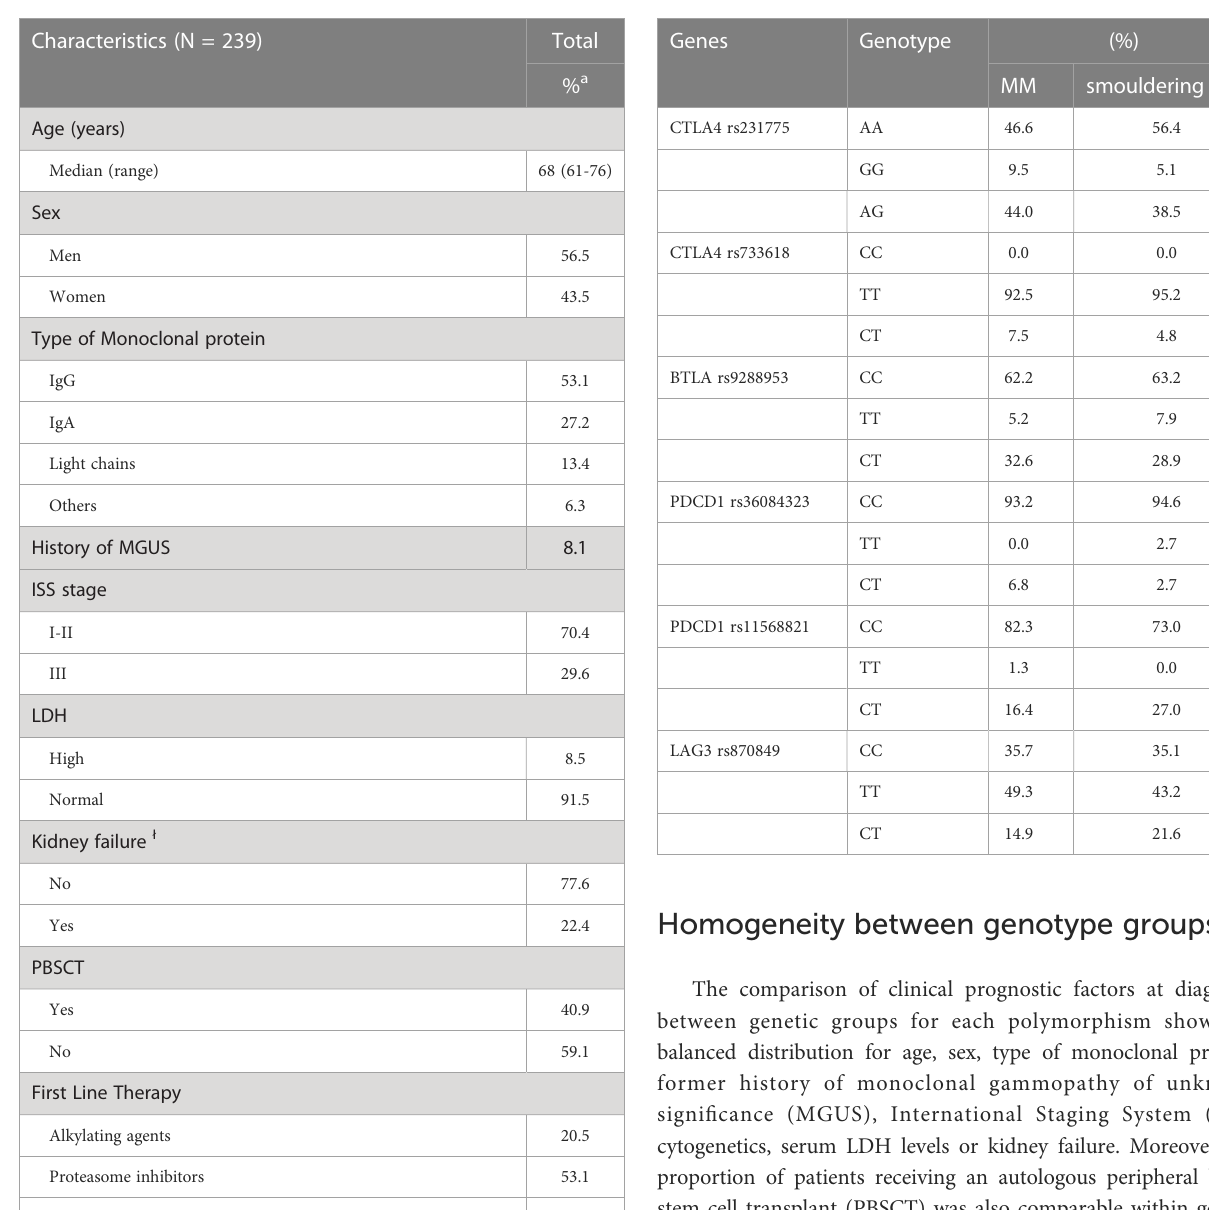
TABLE 1 Clinical characteristics the studied cohort. TABLE 2 Frequencies of genetics polymorphisms in the analysed